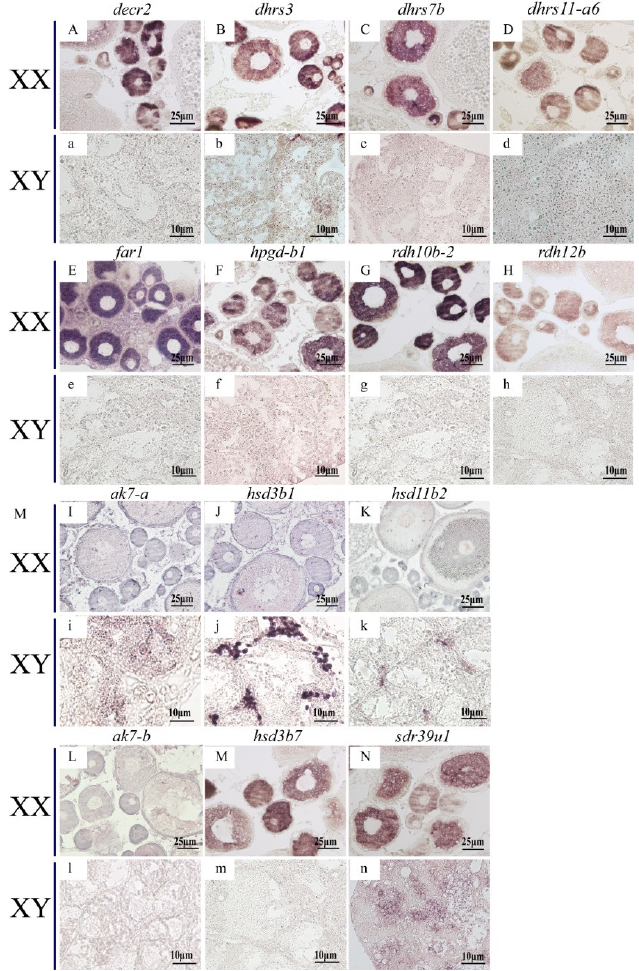
Figure 7. Cellular localization of 14 SDR s in the Nile tilapia gonads at 180 dah by in situ hybridization. Nine of them were expressed exclusively in the cytoplasm of phase I and II oocytes ( A–H , M ), but not expressed in testis ( a–h , m ) . ak7-b was not expressed in neither ovary nor testis ( L and l ). sdr39u1 was expressed in phase II oocytes of ovary ( N ) and spermatocytes of testis ( n ). The other three SDR s were expressed in the Leydig cells of testis exclusively ( i , j , and k ), but not expressed in ovary ( I , J and K ).